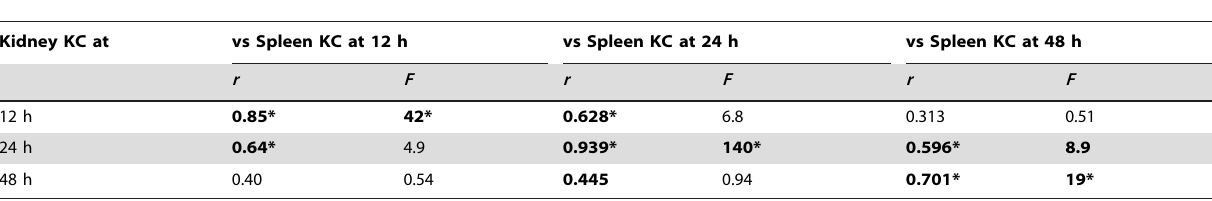
Table 5. Associations between KC concentrations in kidney and spleen.